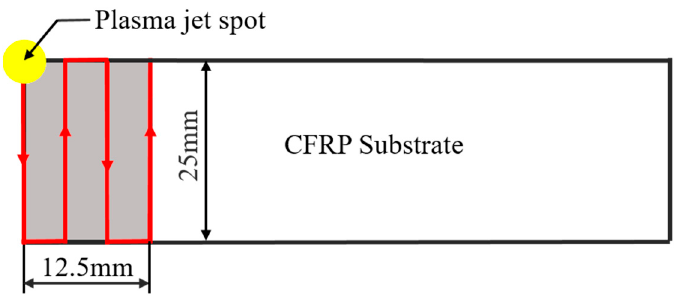
Figure 1. Diagrammatic sketch of the atmospheric pressure plasma treatment equipment.